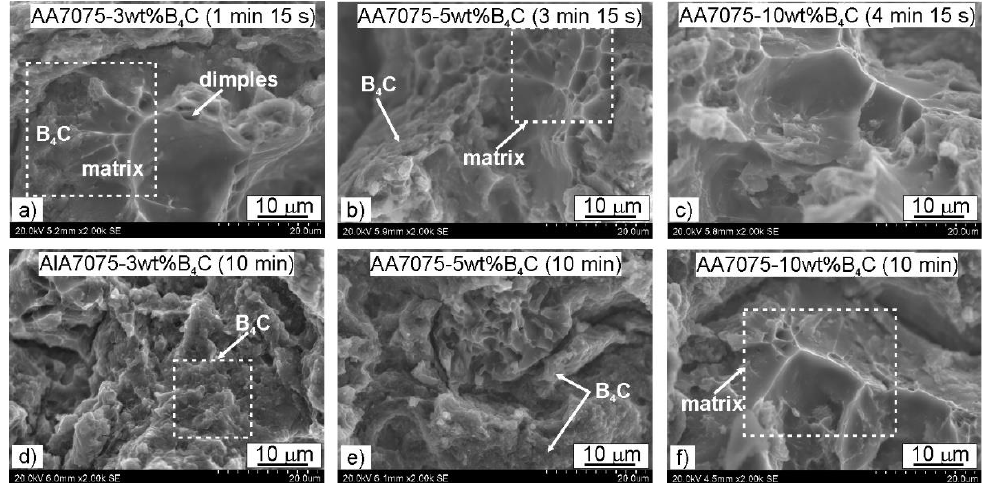
Figure 9. Fracture morphology of AA7075- x B 4 C ( x = 3, 5, 10 wt%) composites after three-point flexural test: ( a ) AA7075-3wt%B 4 C (1 min 15 s), ( b ) AA7075-5wt%B 4 C (3 min 15 s), ( c ) AA7075-10 wt%B 4 C (4 min 15 s), ( d ) AA7075-3wt%B 4 C (10 min), ( e ) AA7075-5wt%B 4 C (10 min), ( f ) AA7075-10 wt%B 4 C (10